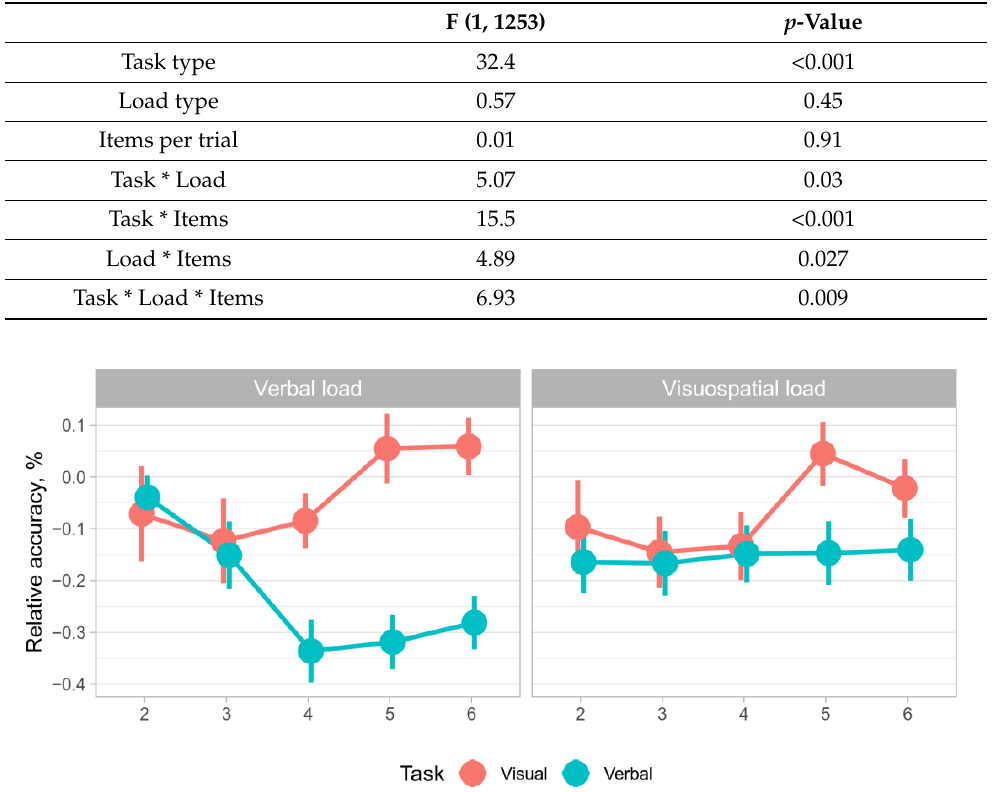
Figure 3. RA as a function of the number of items in the display.